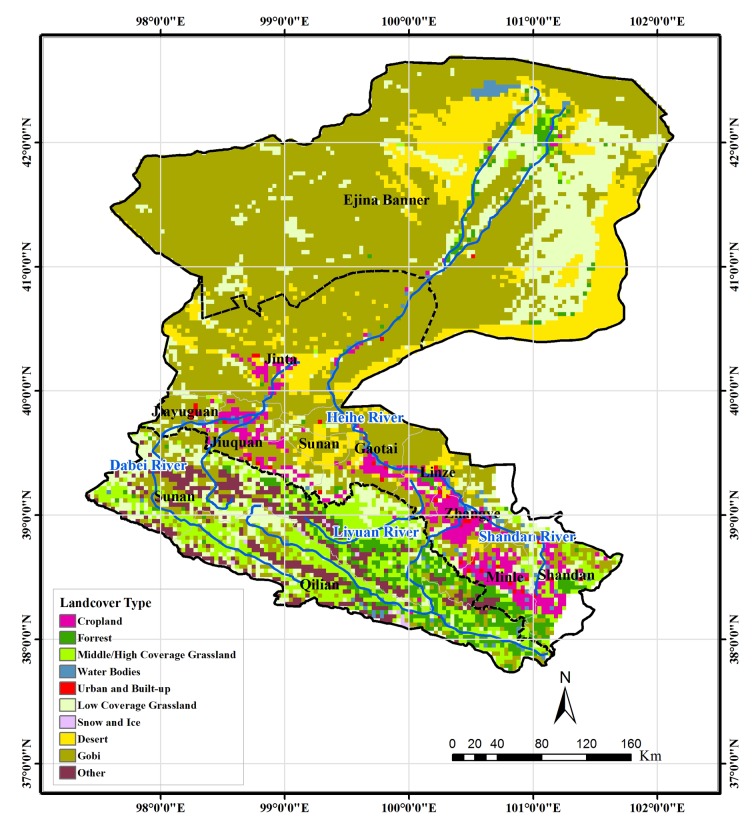
Land cover in the Heihe River Basin.